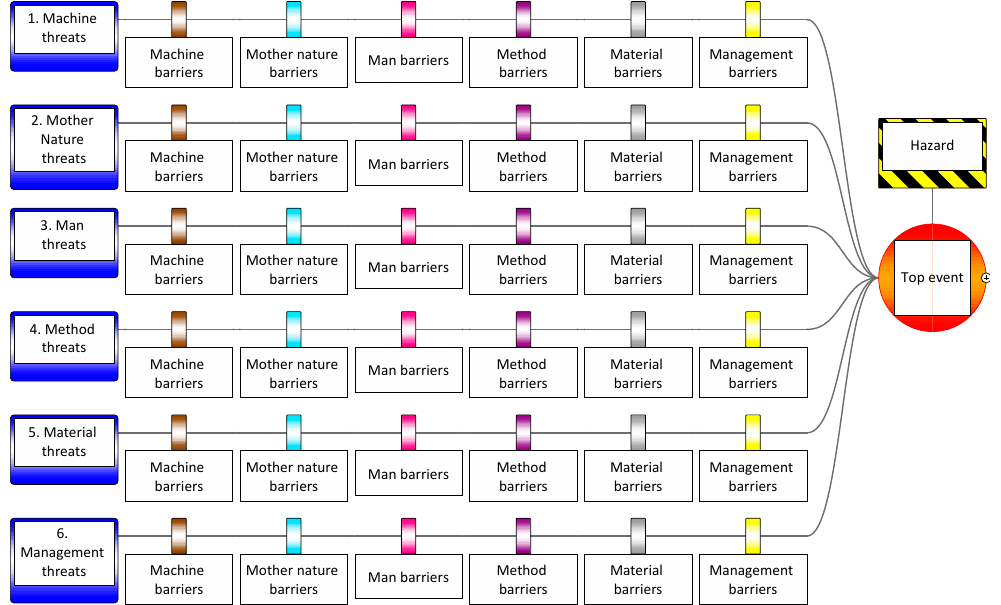
Figure 11. Threat side of the Bowtie diagram with 6M prevention barrier structure.